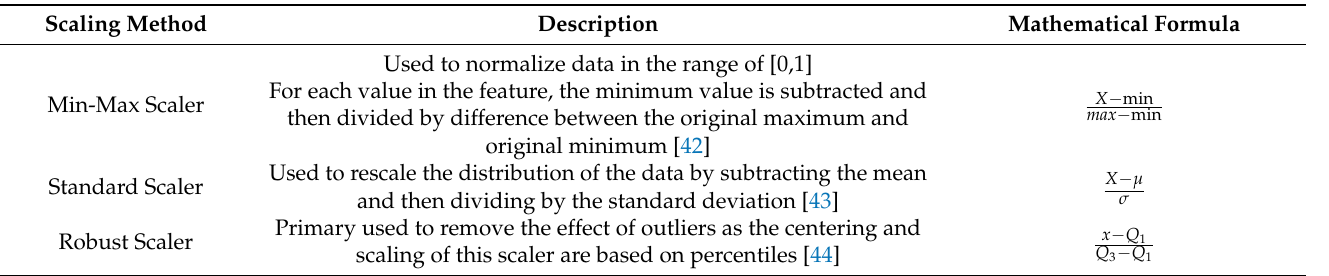
Table 4. Data scaling methods used in this